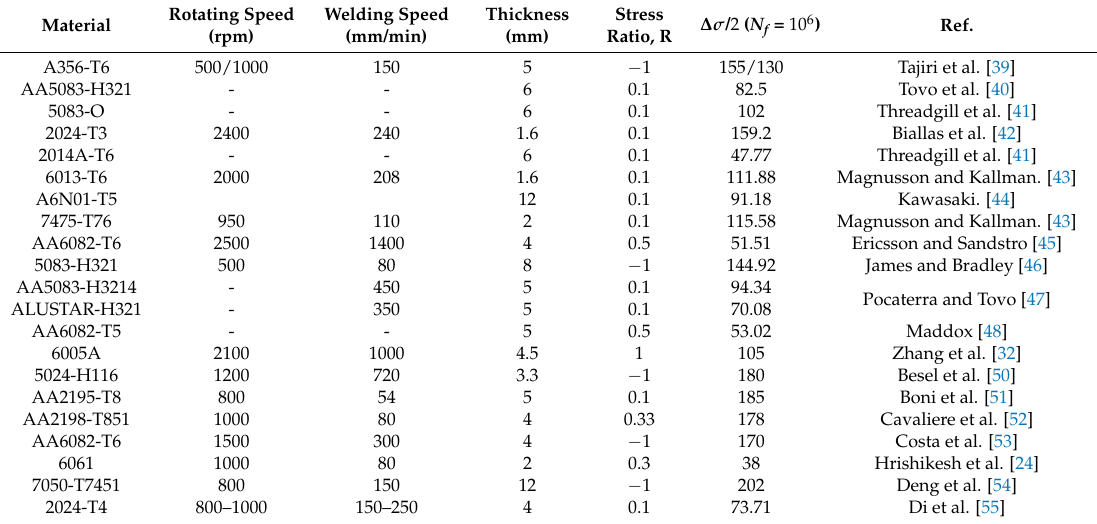
Table 1. A summary of fatigue test data obtained in the